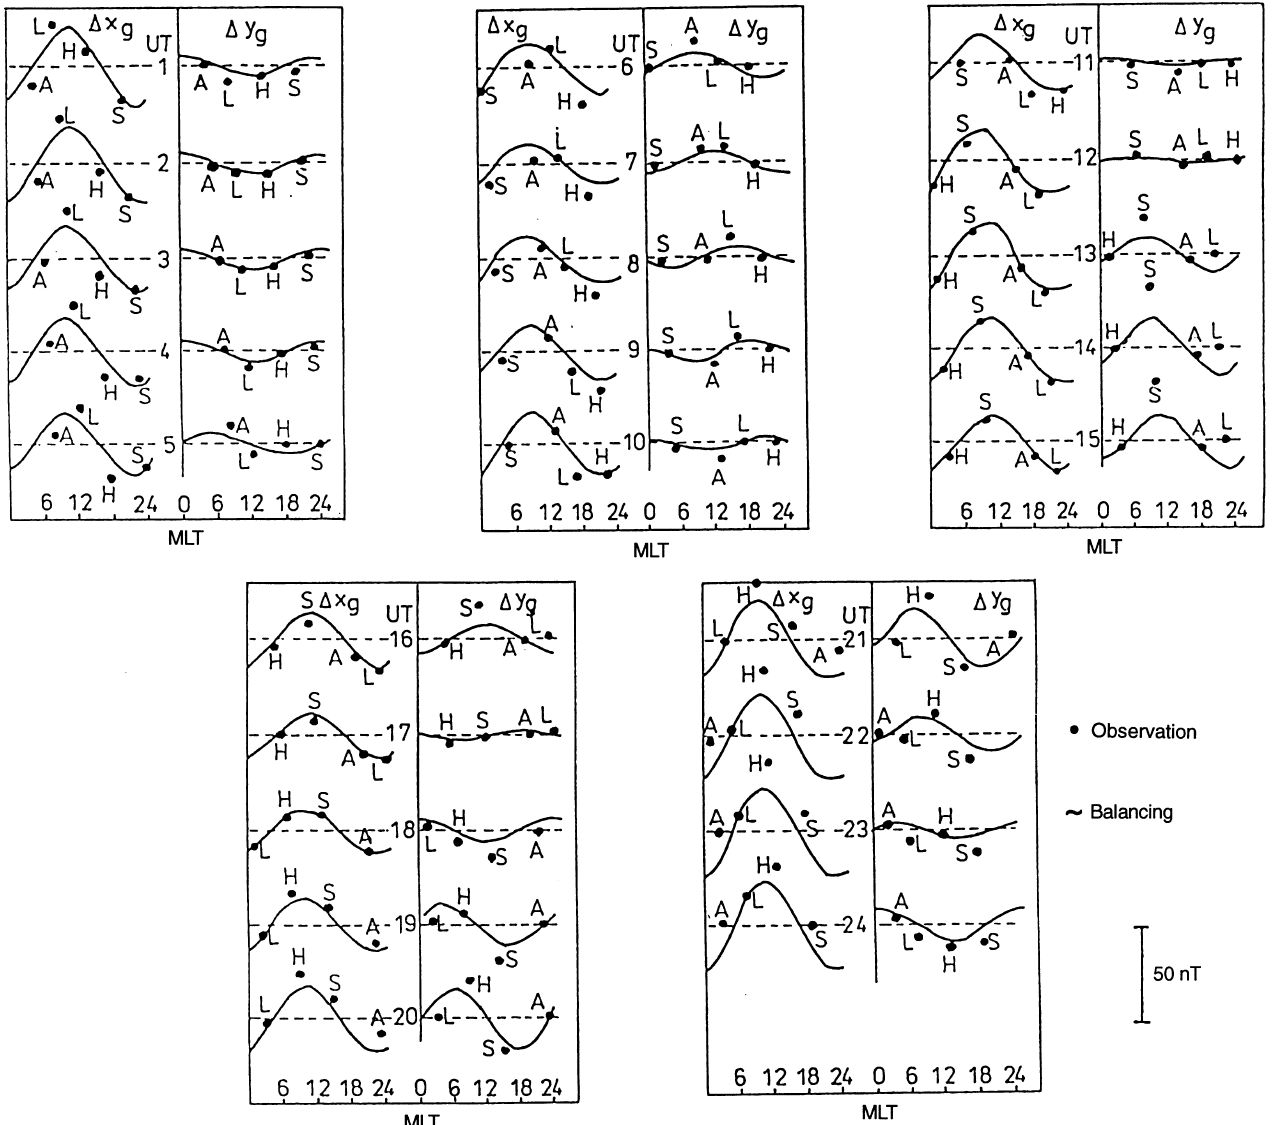
Fig. 8. Averaged local time profiles of ASY calculated from the five international quiet days of February, 1990 ( D Xg , geomagnetic north component, D Yg , geomagnetic east component, H , Honolulu, S , San Juan, A , Ashchabad, L , Lunping)